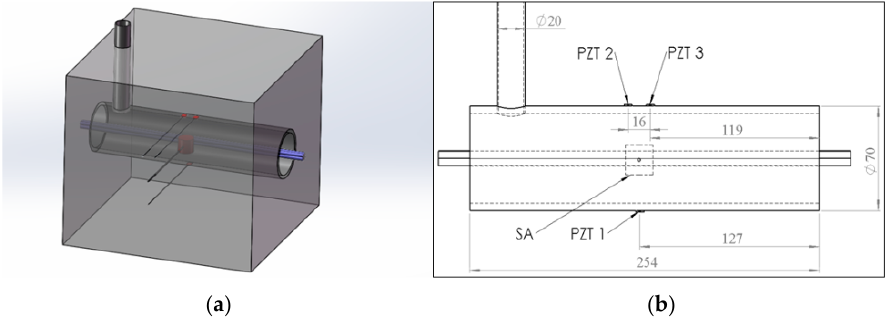
Figure 6. Test specimen: ( a ) the CAD model; ( b ) Schematic of the test specimen.